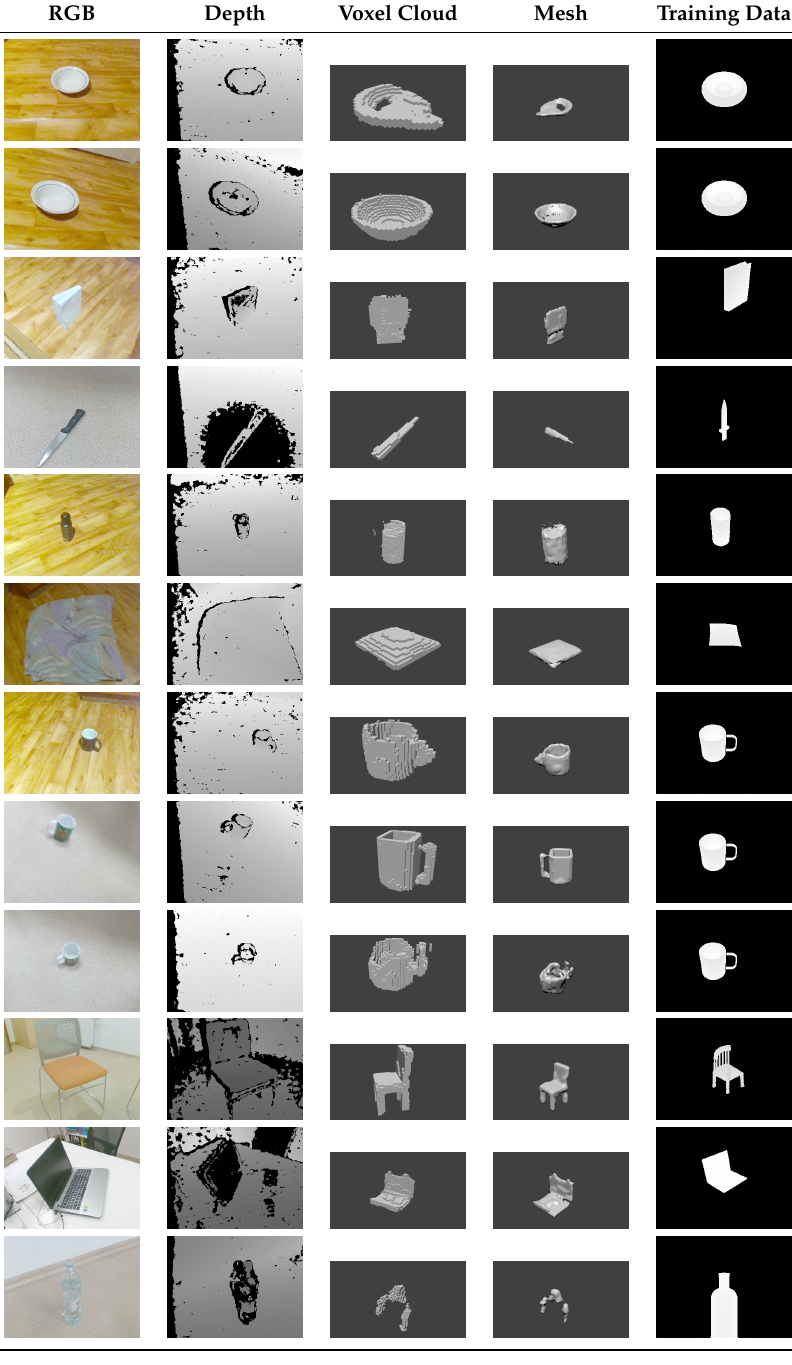
Table 5. Visual evaluation of object reconstruction. Table presents: RGB frame, original depth frame; reconstructed cloud of voxels; triangulated and smoothed surface created using predicted voxel cloud; and a corresponding similar object in the training